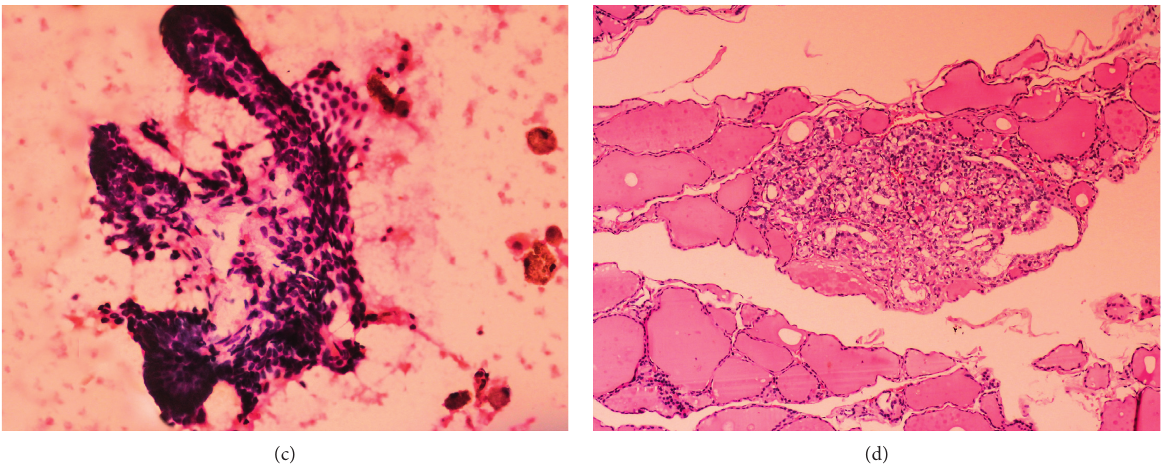
Figure 3: Suspicious for papillary carcinoma (Bethesda category V). (a) One of the follicular cells show nuclear groove (arrow) (H&E × 400). (b) Intranuclear cytoplasmic inclusion (arrow) seen in occasional follicular cell (H&E × 400). (c) Smear shows focal papillaroid structure (H&E × 400). (d) Histopathology of the same showed papillary microcarcinoma (H&E × 100). Table 4: Comparison of risk of neoplasm of our study with another study by Wu et al. [20]. Bethesda category Risk of neoplasm of our study (%) ( n � 100/646)